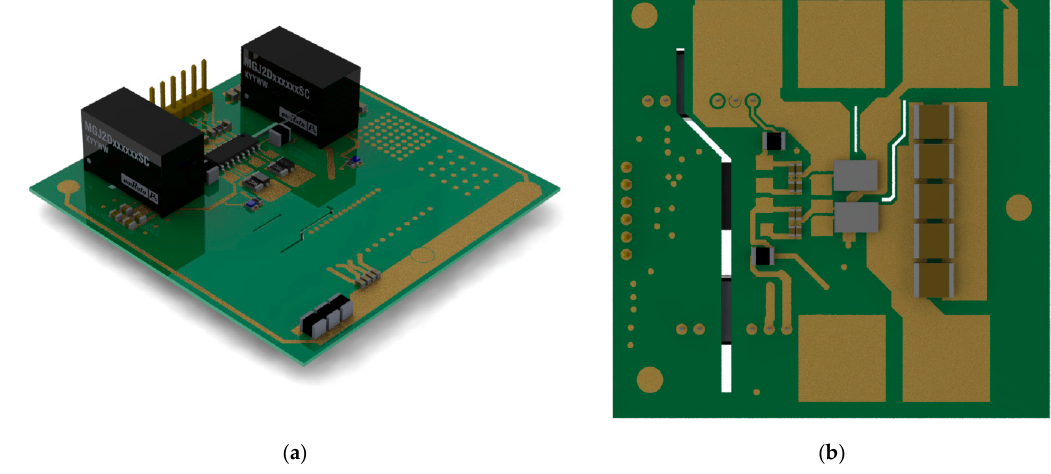
Figure 18. The integrated wire bondless half bridge incorporating chip-scale packaged MOSFETs showing a rendering of ( a ) the top view of the printed circuit board (PCB) with the gate driver, passives, and power supplies; and ( b ) the bottom view showing the MOSFETs and decoupling capacitors.